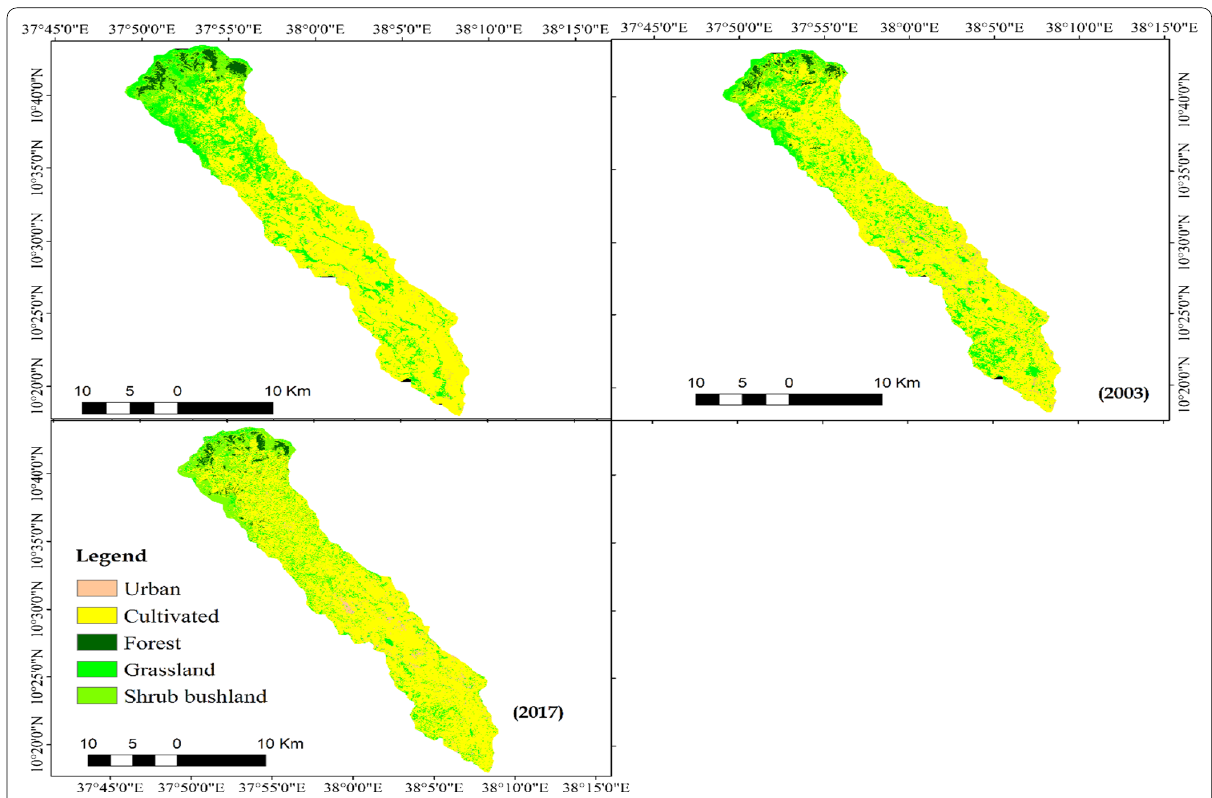
Fig. 6 Classified LULC maps for 1985, 2002, and 2017 in the Muga watershed